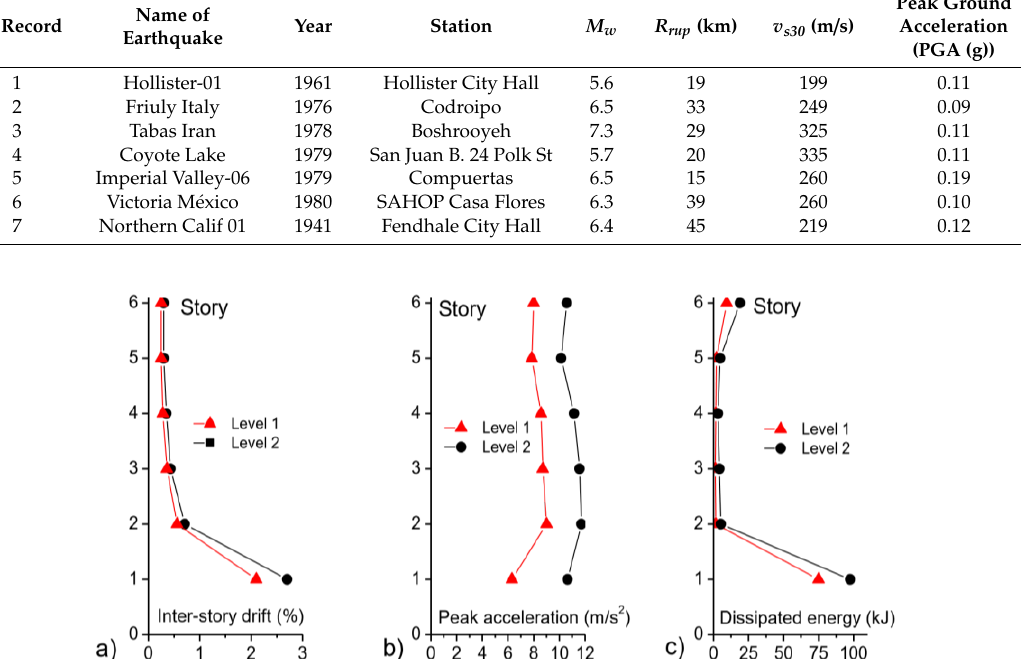
Figure 17. Frame performance in terms of: ( a ) Inter-story drift, ( b ) peak acceleration; and ( c ) dissipated energy .